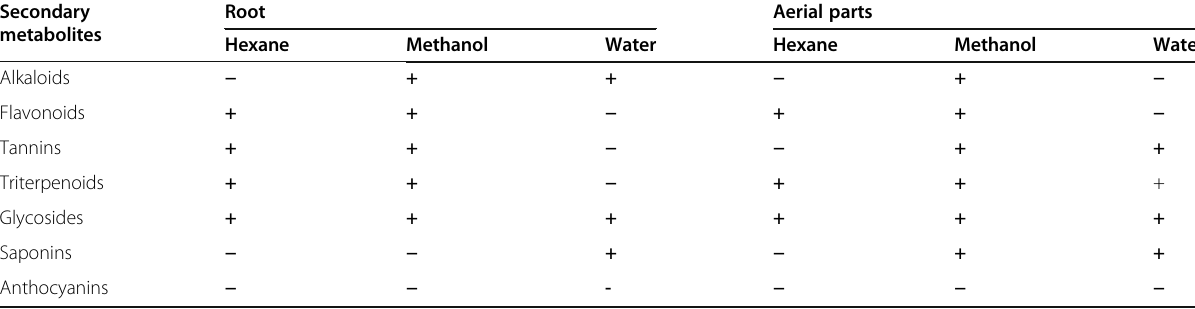
Table 1 Qualitative phytochemical analysis of root and aerial parts of V . coriaceum Secondary metabolites